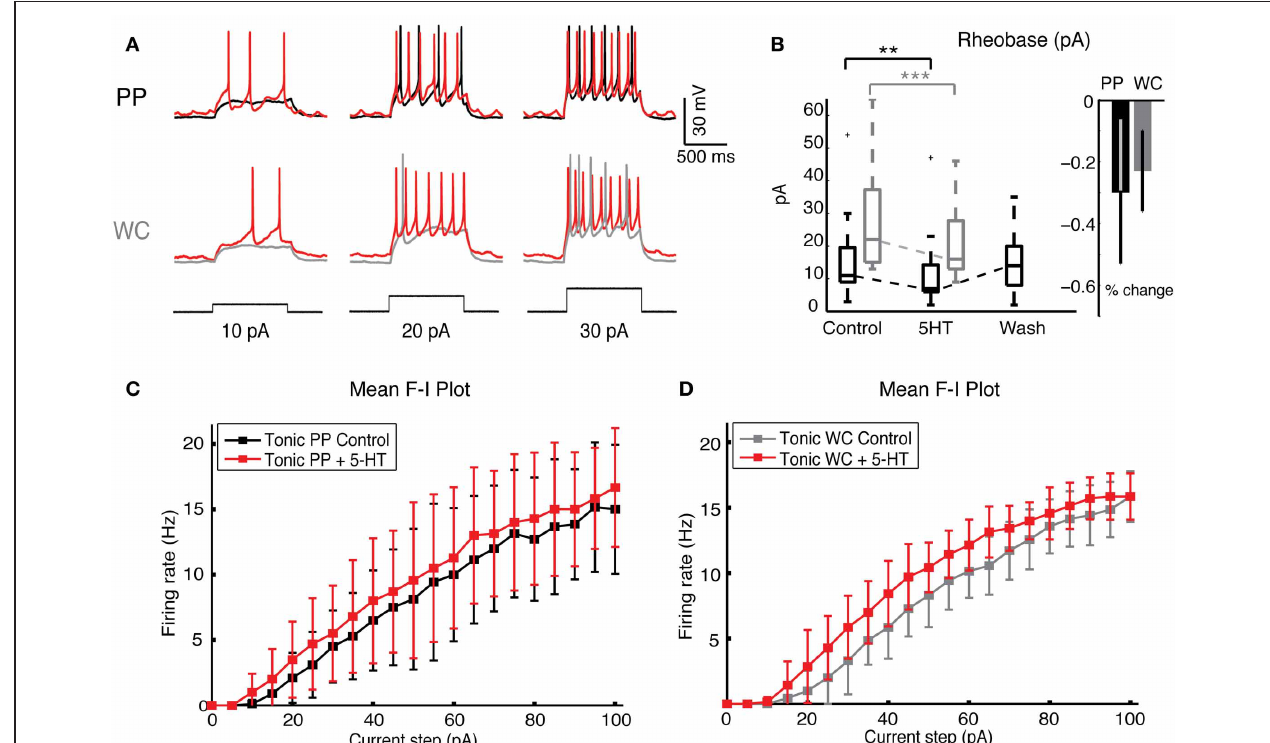
FIGURE 5 | Serotonin increases neuronal excitability in both PP and WC V2a INs. (A) Sample traces from a PPR and from a WCR of V2a INs held at − 60mV, showing injected current steps of 10, 20, and 30pA in black. The increase in firing during 5-HT is shown in red. (B) The rheobase decreased significantly with both PP and WC neurons, but the amount of change was not